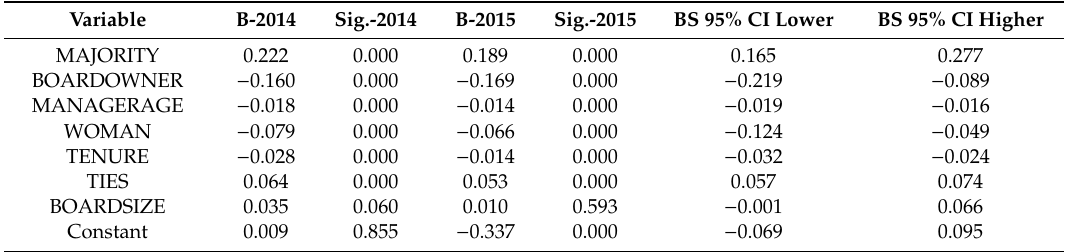
Table A1. Model composed with another fiscal year 2015 and bootstrapping results for the year